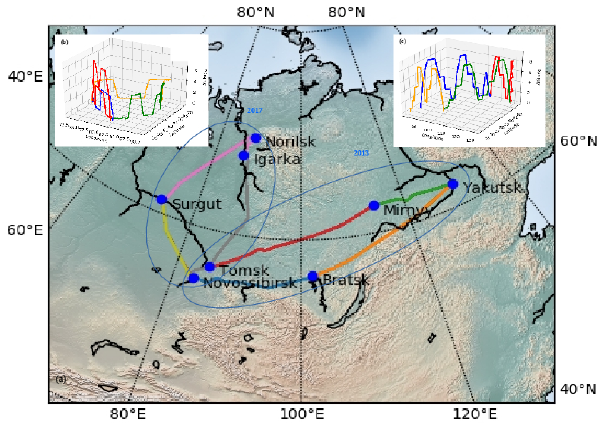
Fig. 1: Map of the 8 aircraft flight tracks carried out in 2013 (eastern loop) and in 2017